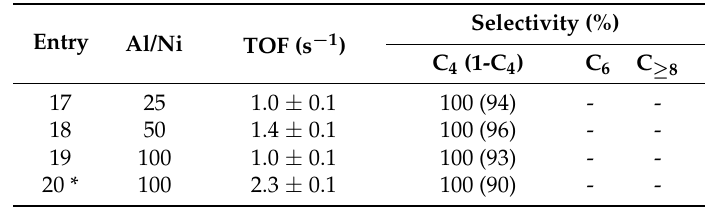
Table 6. Results of catalytic tests of the complex supported on MCM-41 and Al-MCM-41 modified with ionic liquid.